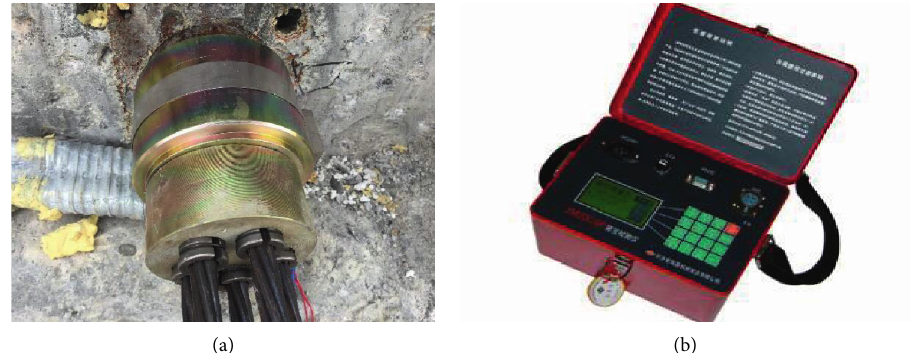
Figure 3: The anchor cable dynamometer: (a) application of electromagnetic sensor to PSC girders; (b) the anchor cable dynamometer reader.